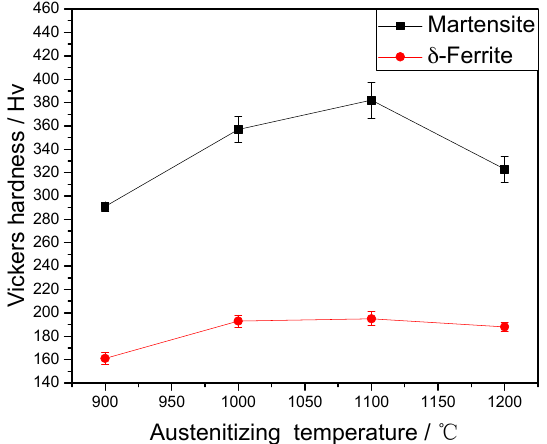
Figure 4. Effect of the austenitizing temperature on the Vickers hardness of δ -ferrite and martensite.